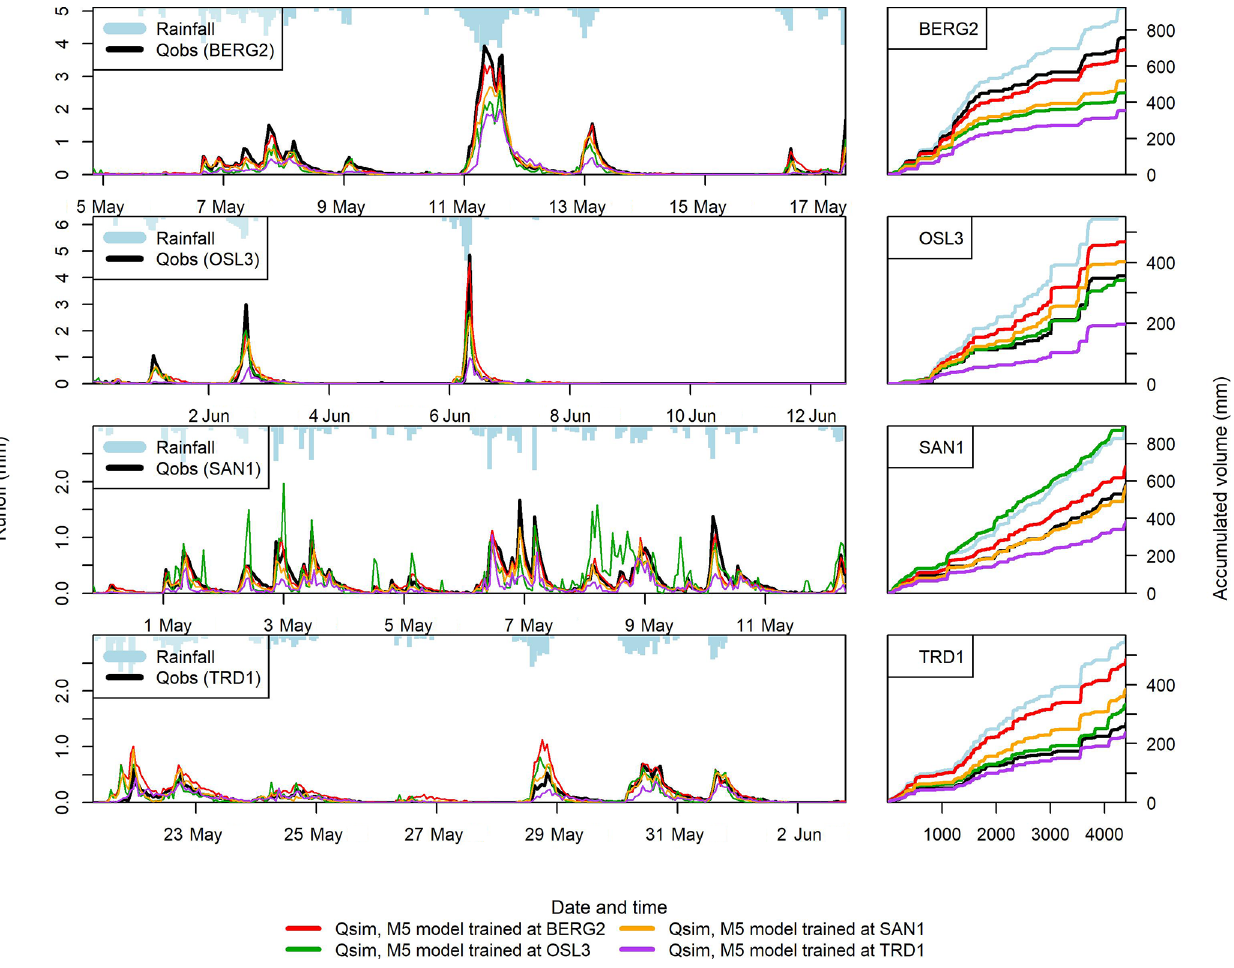
Figure 10. The performance of the transferred ML models at BERG2, OSL3, SAN1 and TRD1. The hydrographs were plotted for selected periods, while the cumulative plots were plotted for the entire testing